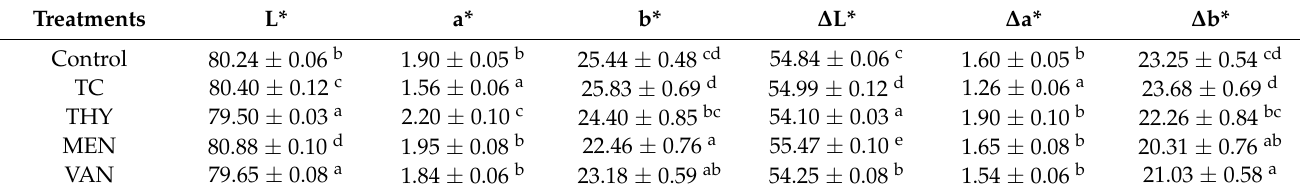
Table 3. Color results of TC, THY, MEN or VAN egg yolk ice creams in mixtures and after ice cream process.